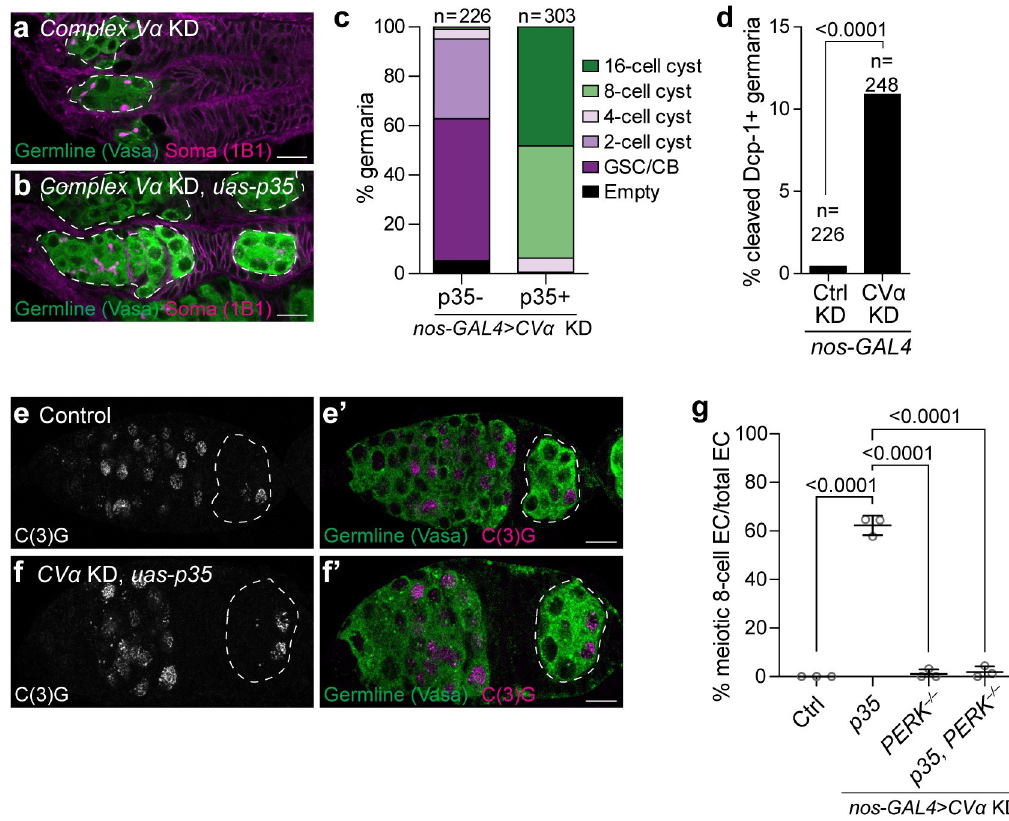
Fig 6. Loss of Complex V induces precocious meiosis and cyst death. (a, b) Representative images of 1 day old CV α KD (a) and CV α KD, P35 overexpression (b) germaria. White-dashed lines demarks the germline. (c) Phenotypic characterization and quantification of germline differentiation stage in germaria of (a, b) . Number of germaria scored above each bar and were studied from 10 or more ovaries, obtained in at least three independent experiments and over two or more crosses. (d) Frequency of cell death positive germaria of 2–3-day old ovaries Control ( mCherry ) KD and CV α KD immunostained with anti-cleaved Dcp1, which marks cells undergoing apoptosis. Number of ovarioles studied and P-value (Fisher’s exact test) are given above bars. (e, f) Representative images of 1 day old Control (e) and CV α KD, P35 overexpression (f) germaria stained with the synaptonemal complex component C(3)G to mark cells in meiosis. See S12E and S12F Fig for confocal slices highlighting number of nuclei. White-dashed lines demark the Region 3 egg chamber. (g) Frequency of meiotic 8-cell cyst egg chambers (EC) for the indicated genotypes ( n = 79 for Control ( no GAL4 ); n = 122 for CV α KD, UAS-P35 ; n = 120 for CV α KD, PERK –/– ; and n = 229 for CV α KD, UAS-P35 , PERK –/– ). Each data point represents a replicate with 20–90 egg chambers analyzed and plotted as mean ± s.d. An ANOVA followed by Tukey post-hoc test was performed. All RNAi and P35 were driven by nos-GAL4 . For all images scale bars represent 10 μ m. For exact genotypes see S2 Table.